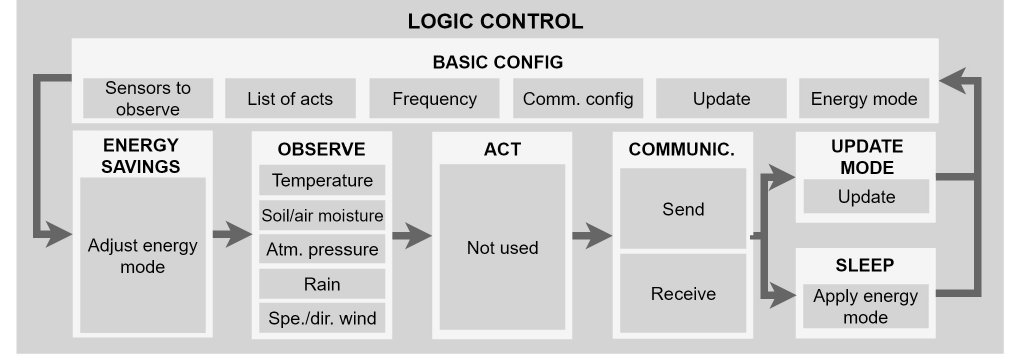
Figure 7. A workflow of the behavior